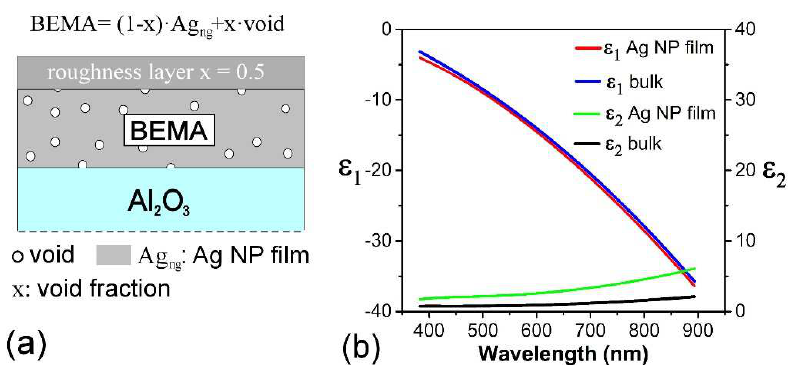
Figure 5. ( a ) Layer model scheme for nanogranular Ag NP film on Al 2 O 3 substrate. The porosity of the film is introduced through the void factor (x) of the BEMA. Nano-granular Ag (Ag ng ) is the host material. Surface roughness is considered through a roughness layer with a fixed void factor of x = 0.5. ( b ) Plot of the model optical dielectric functions ε 1 and ε 2 , of the Ag NP film compared with reference data [80]. Adapted from [78] under the Creative Commons Attribution License 4.0.